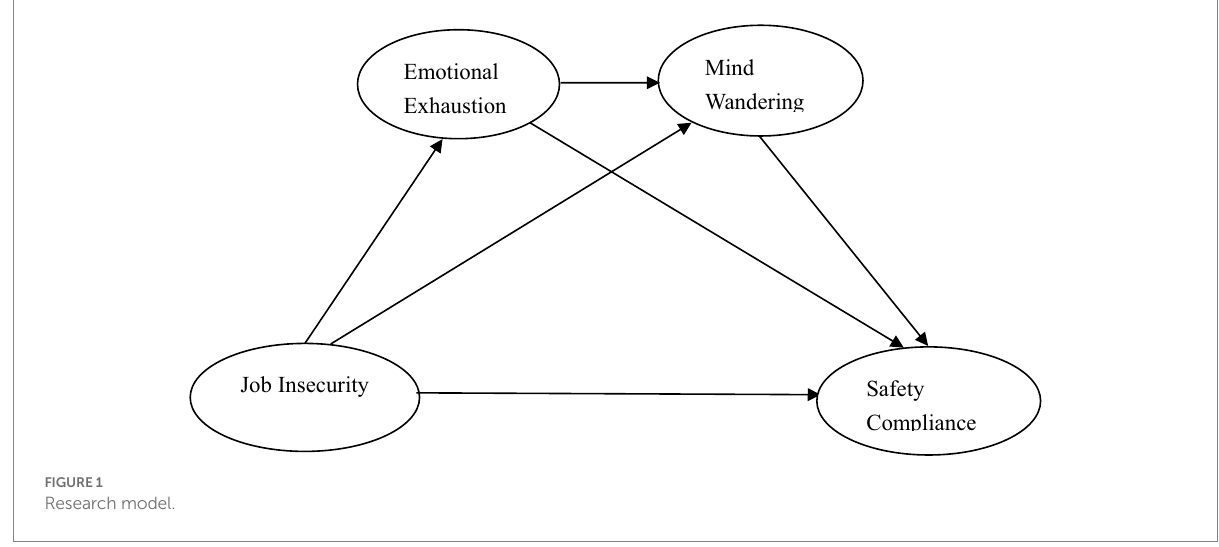
FIGURE 1 Research model.